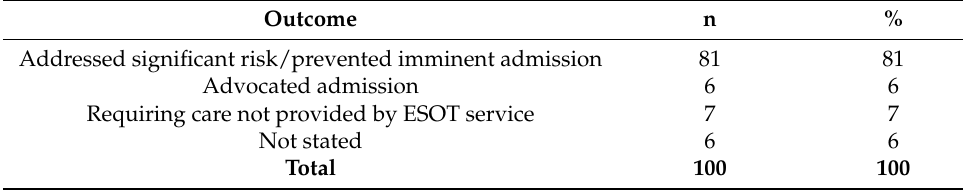
Table 4. Potential for hospital avoidance following ESOT assessment and interventions.